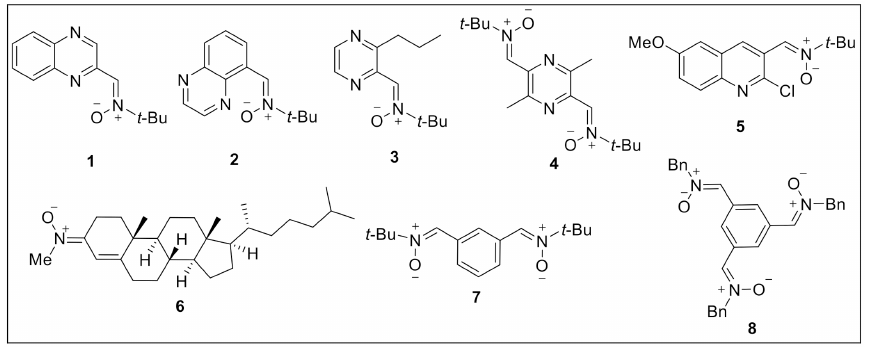
Figure 1. Structures of nitrones 1 – 8 .